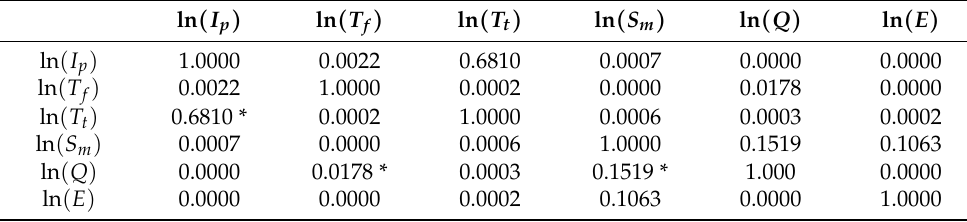
Table 8. p -values.